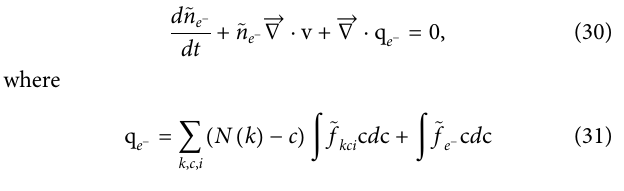
FIGURE 1 | The temperature dependencies of the equilibrium relative concentrations of the atoms, ions and free electrons in the monoatomic ionized oxygen ( N L is Loschmidt